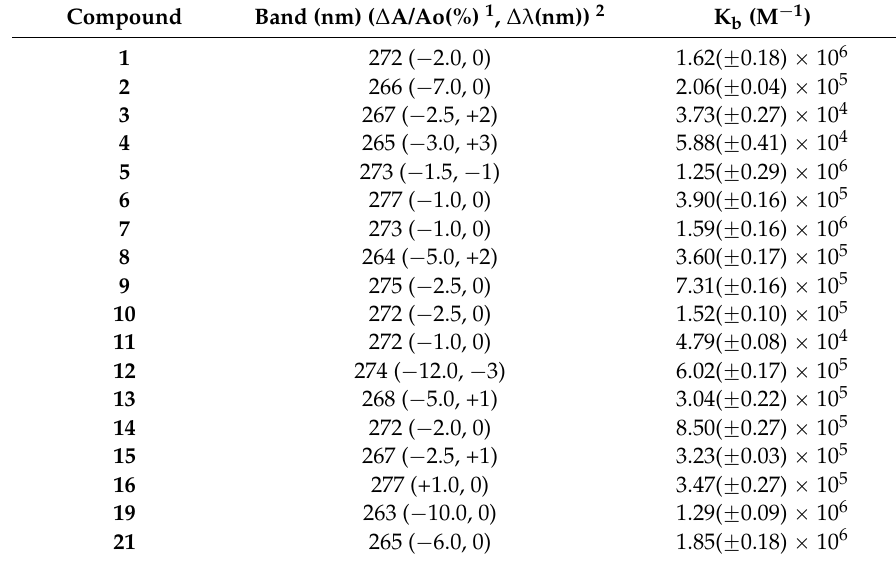
Table 2. UV spectral features of the interaction of selected compounds 1 – 16 , 19 and 21 with CT DNA; UV - band ( λ , nm) (percentage of observed hyper-/hypo-chromism ( Δ A/A 0 , %), blue-/red-shift of the ´ 1 λ max ( ∆ λ , nm)) and DNA-binding constants (K b , M